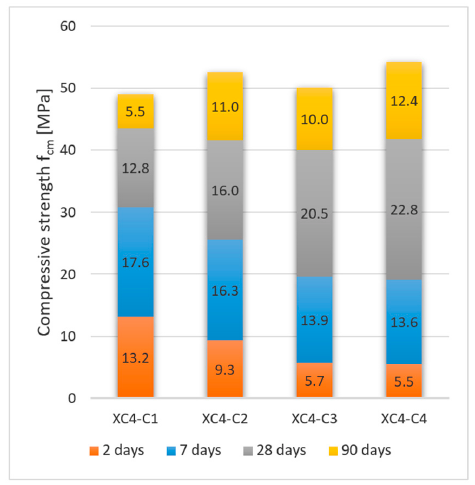
Figure 5. Compressive strength f cm —concretes XC4. Table 7. Properties of XC4 concretes with CO 2 emission level.